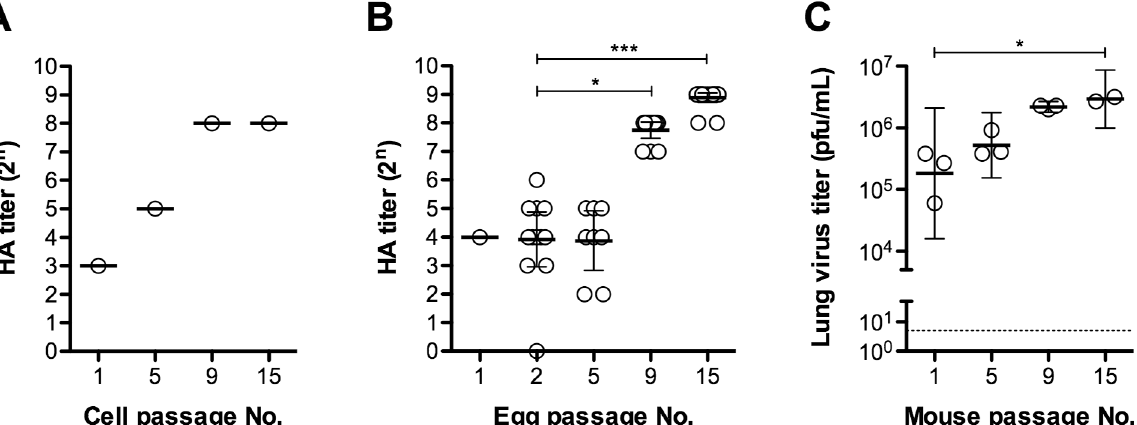
Fig 1. Growth potencial of A/N after multiple passages in cells, eggs or mice. (A) Hemagglutinin (HA) titers of A/N that was both isolated and passaged in cells were determined from the 1 st , 5 th , 9 th , and 15 th passages. HA titers in each well of the 6-well culture plate were similar. Therefore, wells were pooled and values represent the HA titer of the pooled wells. (B) HA titers of A/N that was isolated and passaged in eggs (n = 8 – 18, except for isolation) were determined from the 1 st , 2 nd , 5 th , 9 th , and 15 th passages. Statistical analysis of the 2 nd passage was performed. Asterisks * and *** indicate p < 0.05 and p < 0.001, respectively. (C) Mice were infected with cell-isolated A/N and lung washes were collected and used to infect the next group of mice. Lung virus titers of mouse-passaged A/N were determined from the 1 st , 5 th , 9 th , and 15 th passages. Statistical analysis of the 1 st passage was performed to ascertain adaptation in mouse lungs. The asterisk * indicates p <